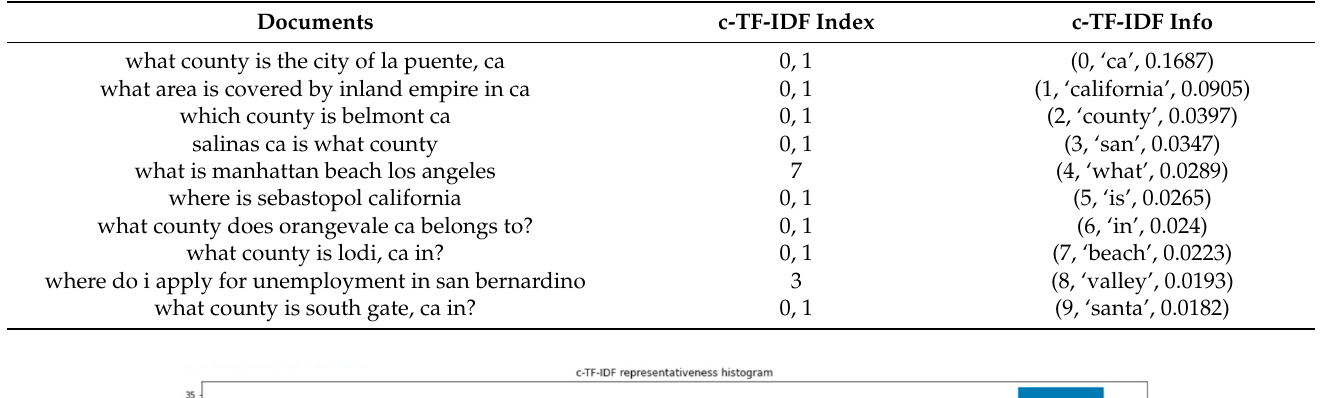
Table 11. Manual annotation example for topic 4 regarding c-TF-IDF representativeness. We labeled each document (column Documents) with the index of relevant c-TF-IDF words (column c-TF-IDF index). Column c-TF-IDF info does not have any relation with documents column. For simplicity, we